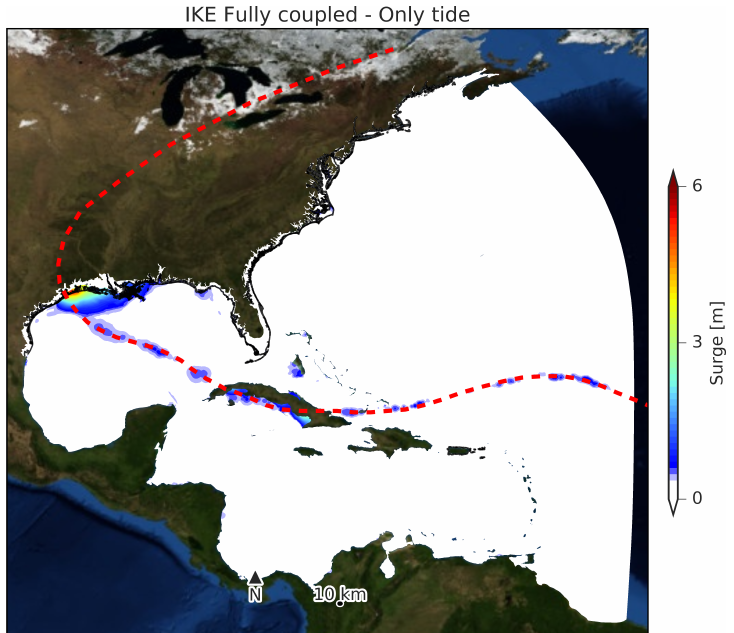
Figure 11. Surge level is computed by subtraction of tide elevation from maximum total water level for the whole Hurricane Surge On-demand Forecast System (HSOFS) mesh. Hurricane Ike’s best track is shown by a red dashed-line. All model configurations and results are pre-decisional and for official use only.